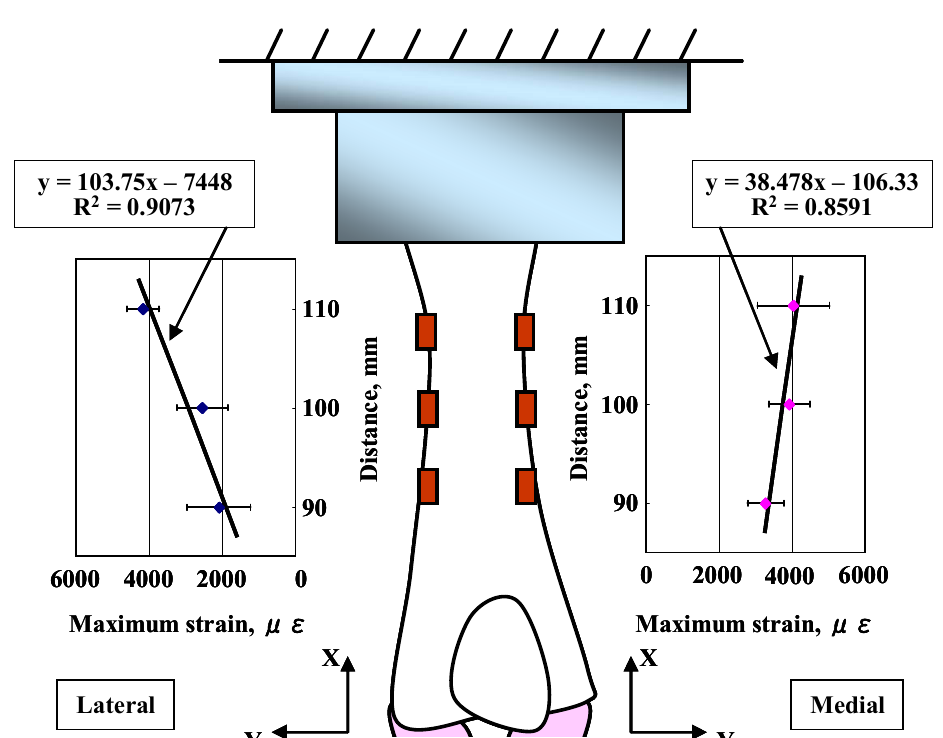
Fig. 5 The maximum strains measured on impact from each direction (lateral and medial). The left bars represent the values for the medial side of the femur. The right bars represent the values for the lateral side of the